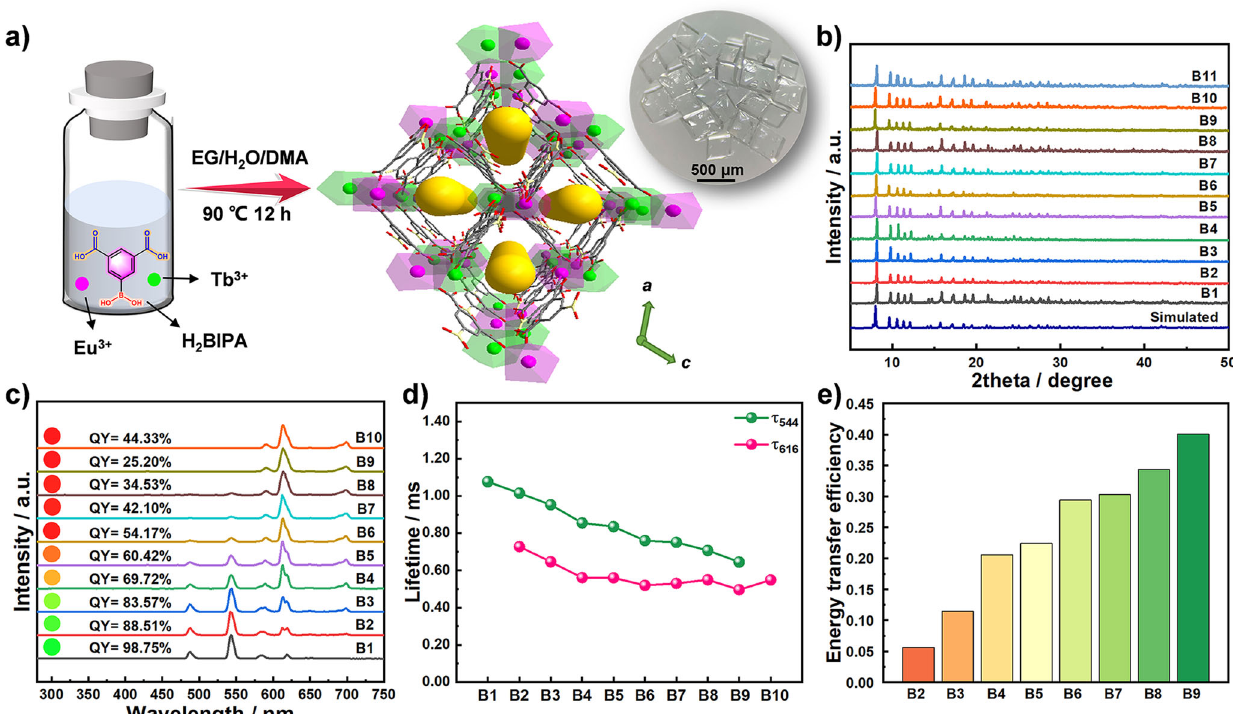
Fig. 1 Synthesis and luminescent properties of B1-B11. a Synthesis and structure of B7 with its photo under natural light. Atom codes: Tb (green), Eu (pink), C (gray), B (yellow) and O (red). Partial hydrogen atoms and solvent molecules are omitted for clarity. b PXRD of B1 - B11 . c Solid-state fl uorescence spectra of B1 - B10 excited at 254 nm. The pictures of B1 - B10 were obtained under 254 nm UV light. QY is absolute quantum yield. d Solid-state lifetimes of B1 - B10 excited at 254 nm. e Energy transfer ef fi ciencies of B2 - B9